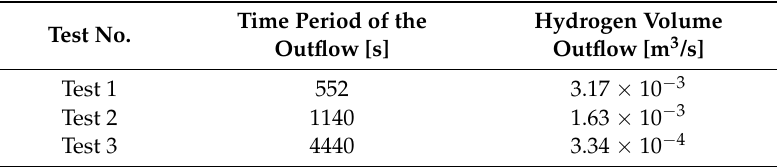
Table 2. Time period and volume of hydrogen